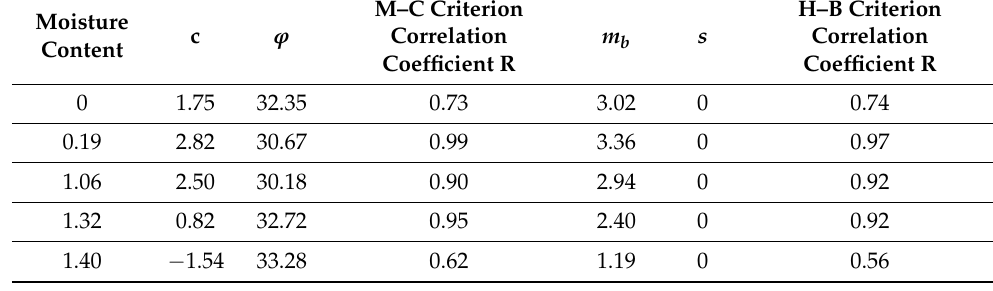
Table 3. Residual strength fitting coefficient of the yield criterion.